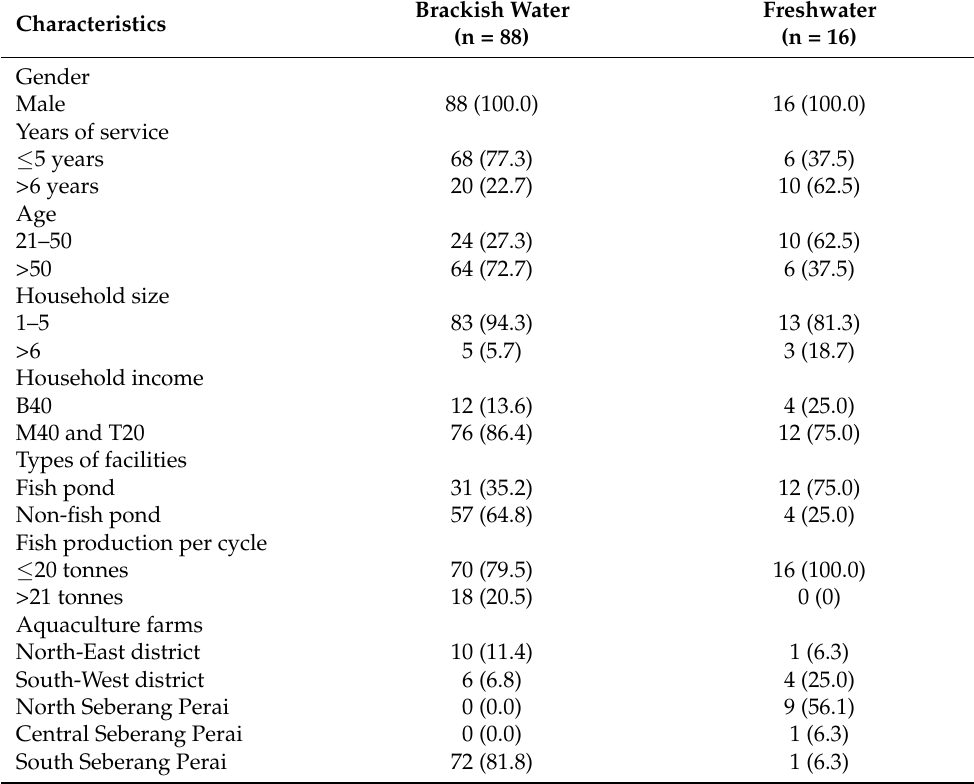
Table 2. Baseline characteristics of brackish water and freshwater aquaculture workers.